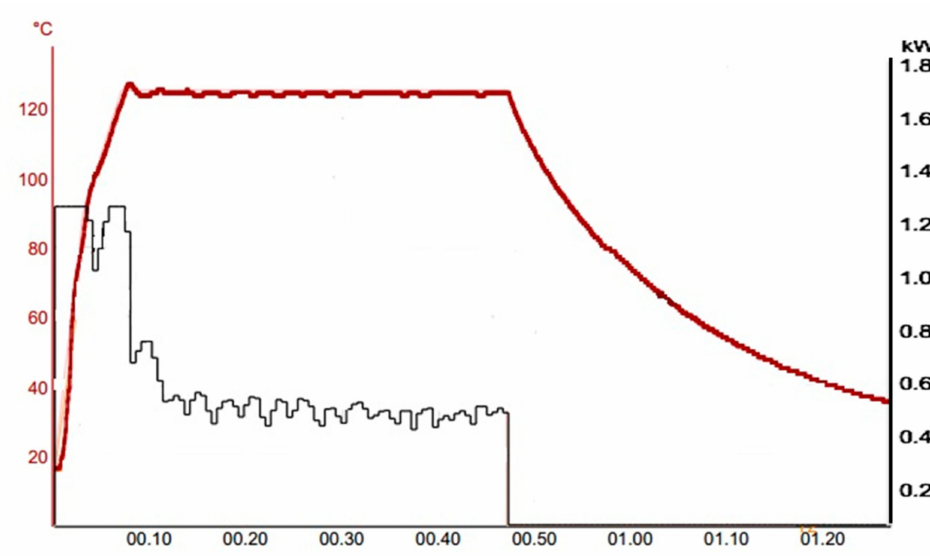
Figure 1. Temperature/power vs. time extraction program